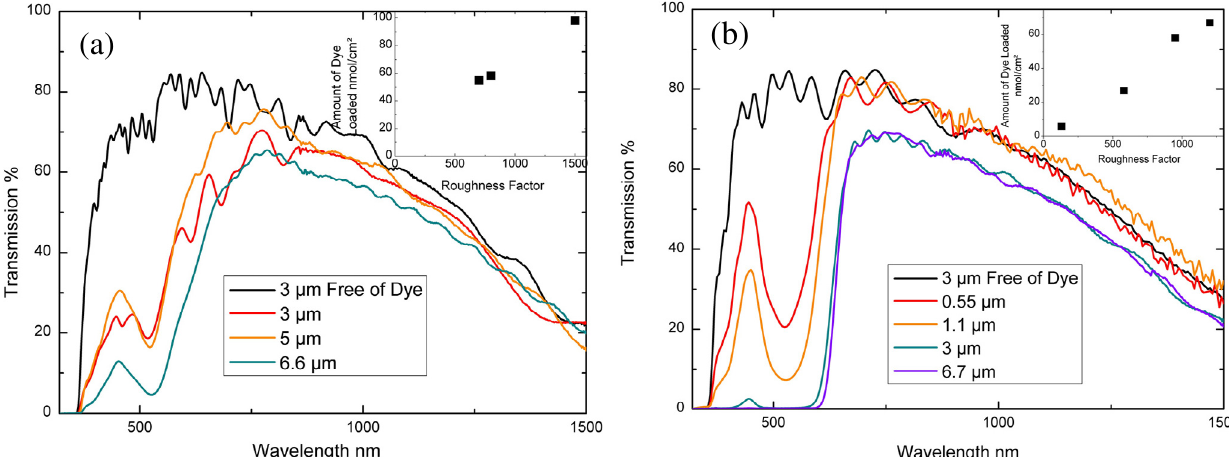
Fig. 5. Total transmission of nanoporous structures loaded during (a) 2 h with N719 and (b) 15 h with D149 for increasing charge density consumed. Total transmission of a film prepared with deposition of 4 C/cm 2 is given as reference. Insets of each figure represents the evolution of the amount of dye molecules loaded with respect to the developed surface calculated from the transmission data.